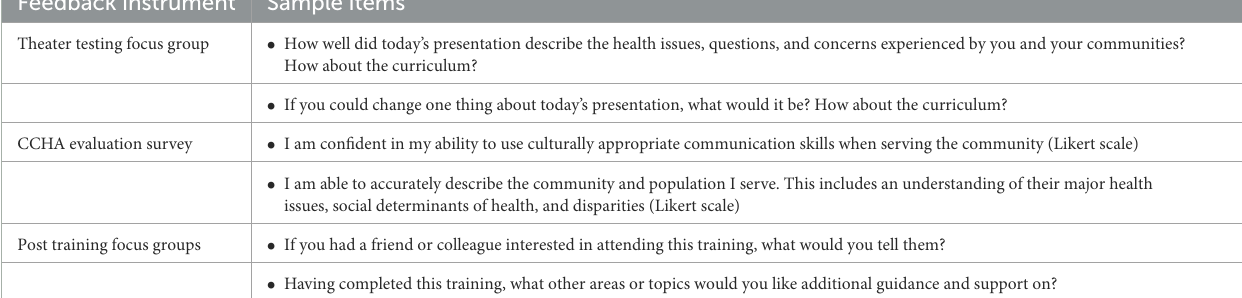
TABLE 3 Feedback instrument sample